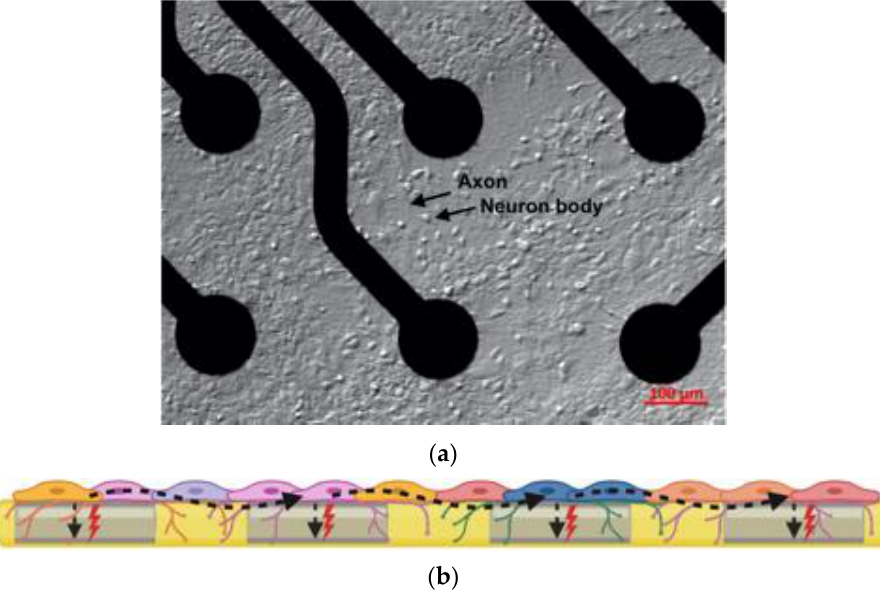
Figure 1. ( a ) hCNS-Neuron Cells culture on an MEA well, on the top of the recording electrodes; the black arrows highlights an axon and a cellular body, 10 × magnification; ( b ) a schematic “cross-sectional” overview of the MEA plate technology: spontaneous extracellular action potentials or spikes (red thunders) originated by different neuron types are recorded by the electrodes (gray rectangles). Besides the spontaneous cellular spikes registered by a single or multiple electrodes, the electrochemical signal can also travel across the neural network, indicating synaptic communication (denoted by undulated black dashed arrows).